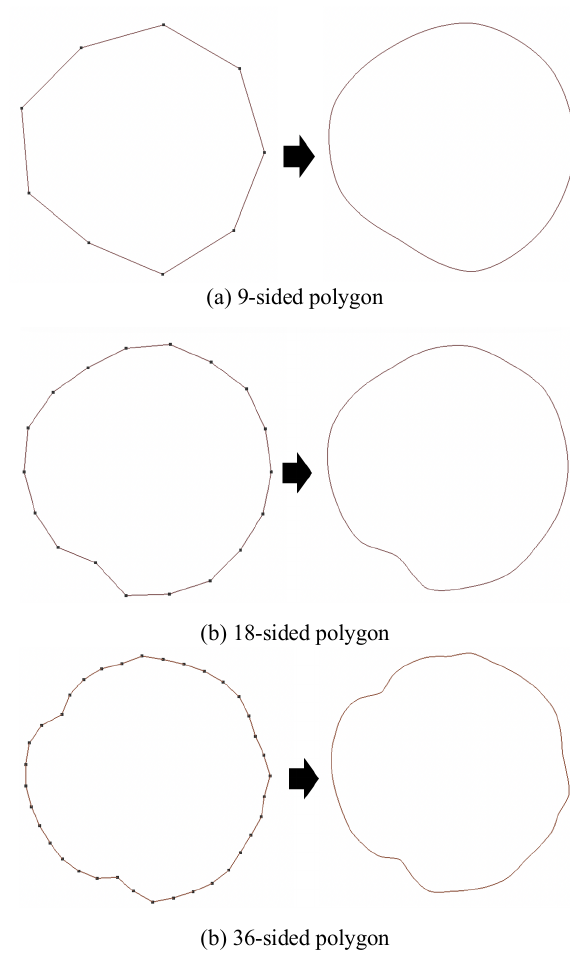
Figure 10. Application of four-point subdivision scheme